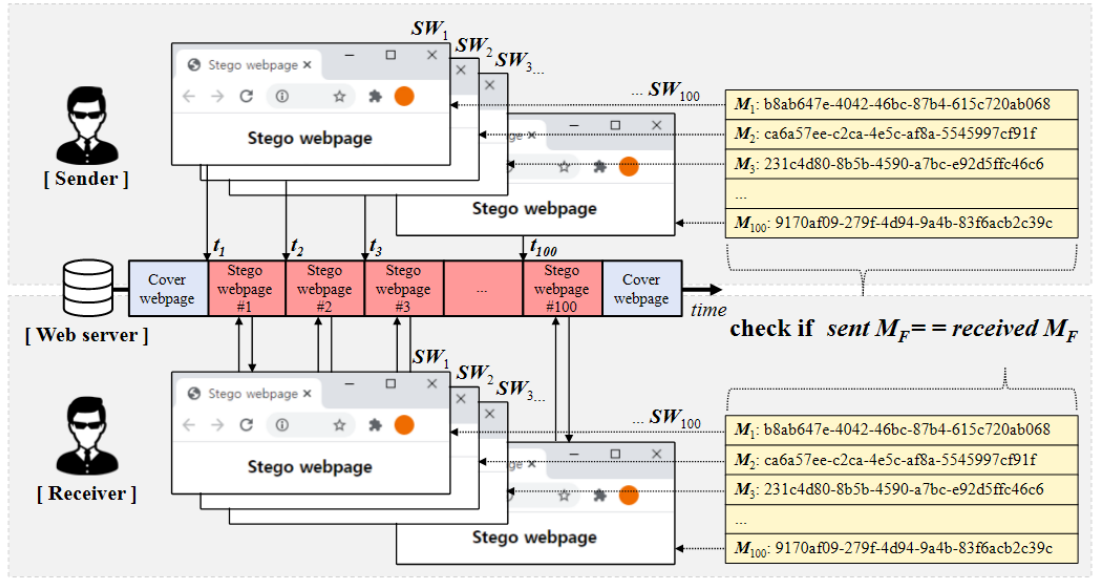
Figure 10. Experimental design of Experiment 1. Part 1.